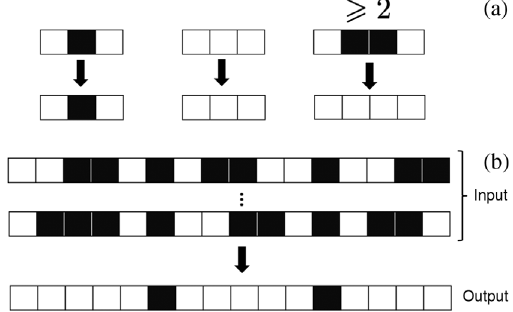
FIG. 1. (a) Filter extracting single ones and their positions from sequences of ones and zeros. Here the filter pattern is a single one. Ones and zeros are shown as black and white pixels, respectively. (b) A number of different inputs produce the same output. This number is the degeneracy of the output.